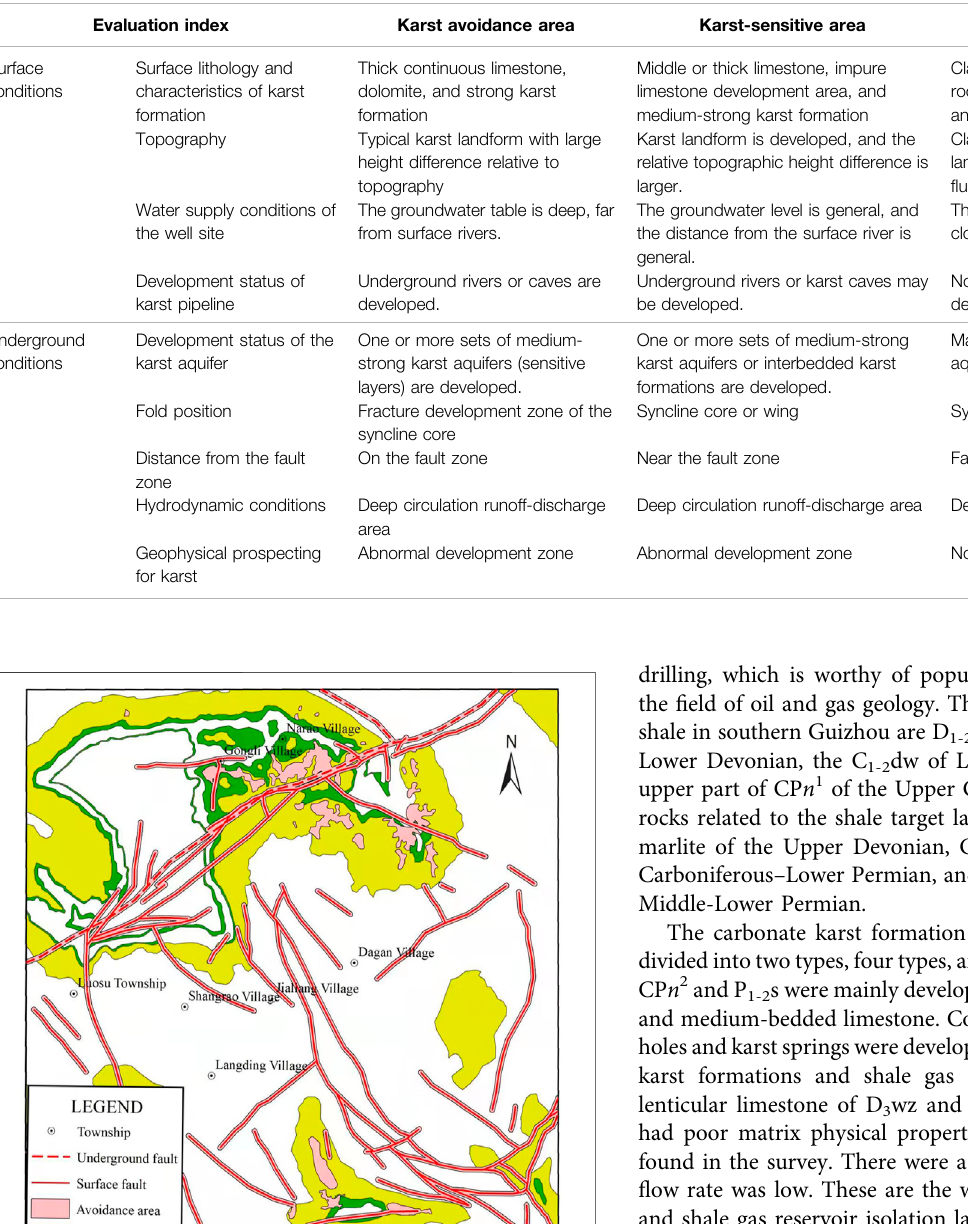
TABLE 3 | Division table of karst sensitivity evaluation for shale gas exploration.